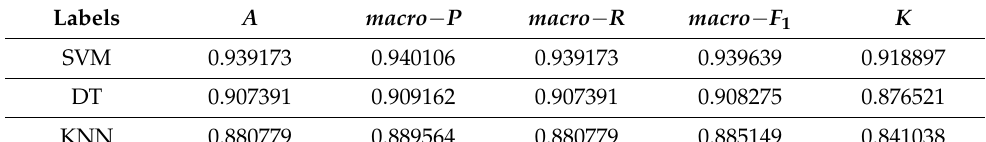
Table 5. Statistical table of model numerical indicators of different algorithms.